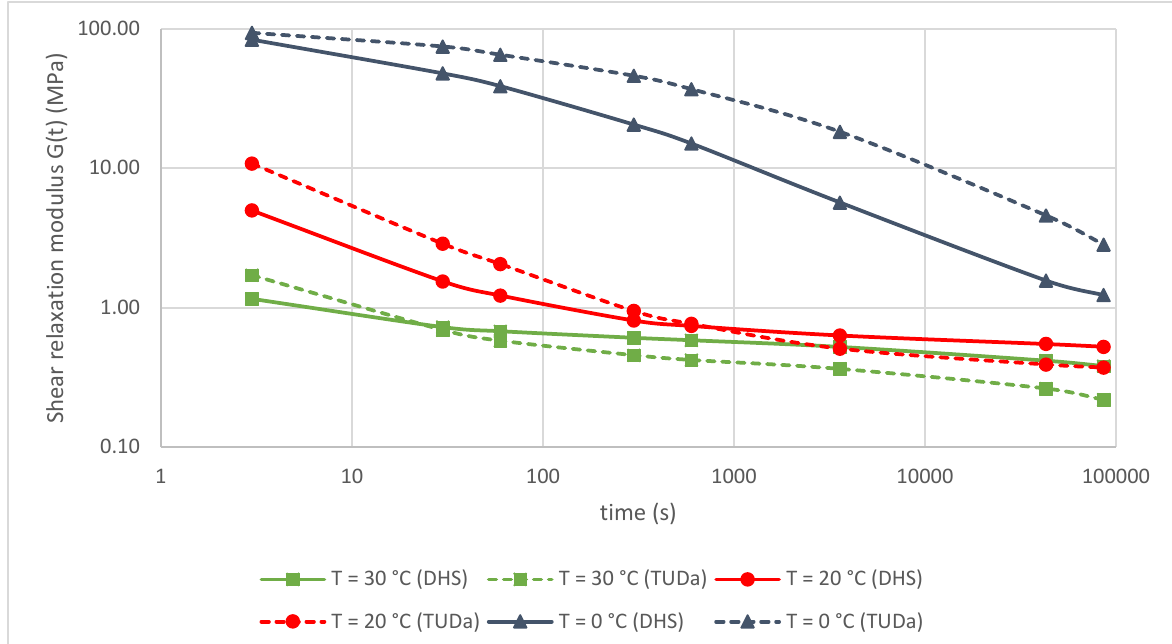
Fig. 3 Shear relaxation modulus for conventional PVB for durations between 3s and 24 hours at different temperatures for the model of D’Haene and Savineau (DHS - solid lines) and Schuster and Scheider (TUDa - dotted lines).